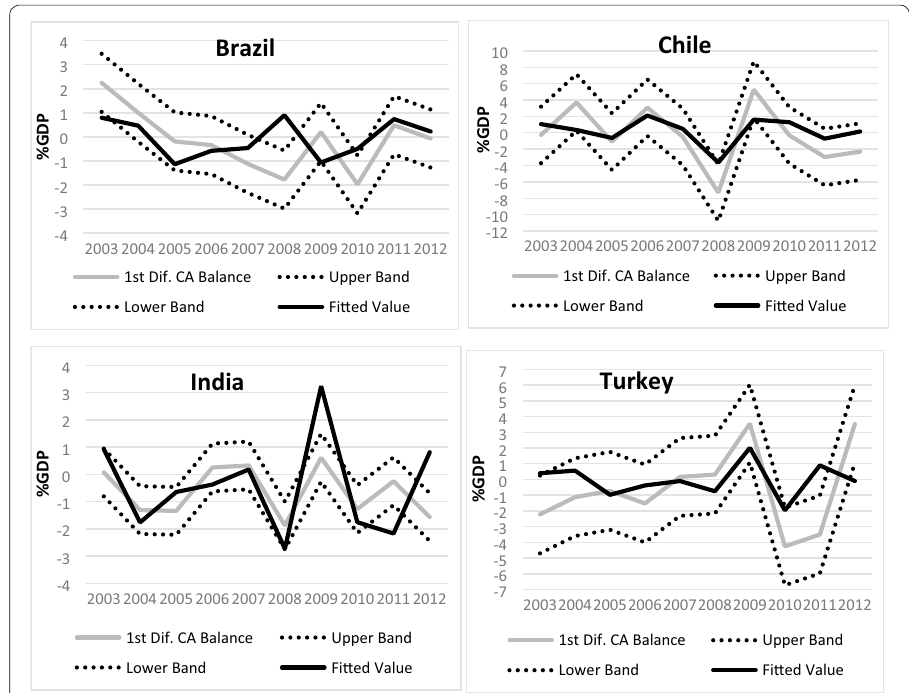
Fig. 3 Predicted first difference of current account balance with political stability and financial development for some of the emerging